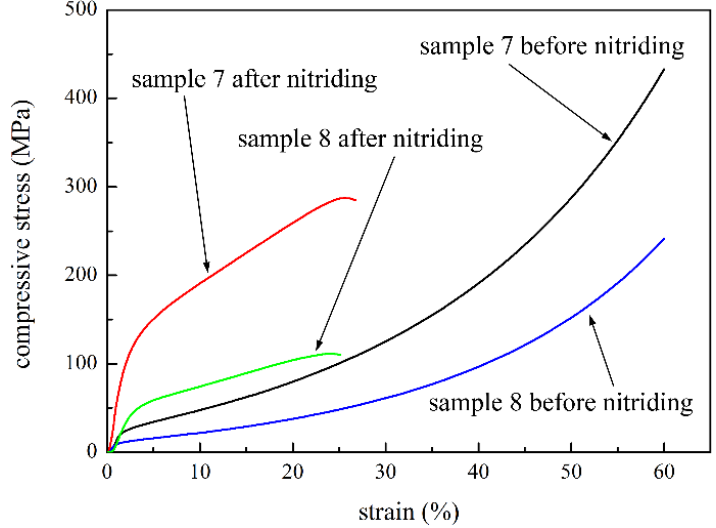
Figure 7. Compressive curves of the samples with and without nitriding by loose sintering.